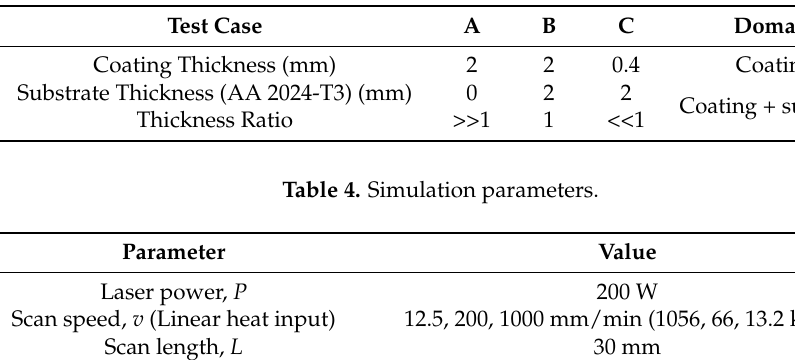
Figure 4. Structural meshed model of the coating-substrate system for the thermo-mechanical analysis. Table 3. Case studies designation.